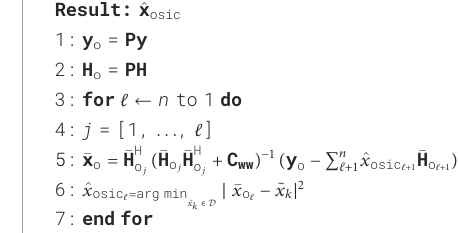
Algorithm 2. MMSE-OSIC.